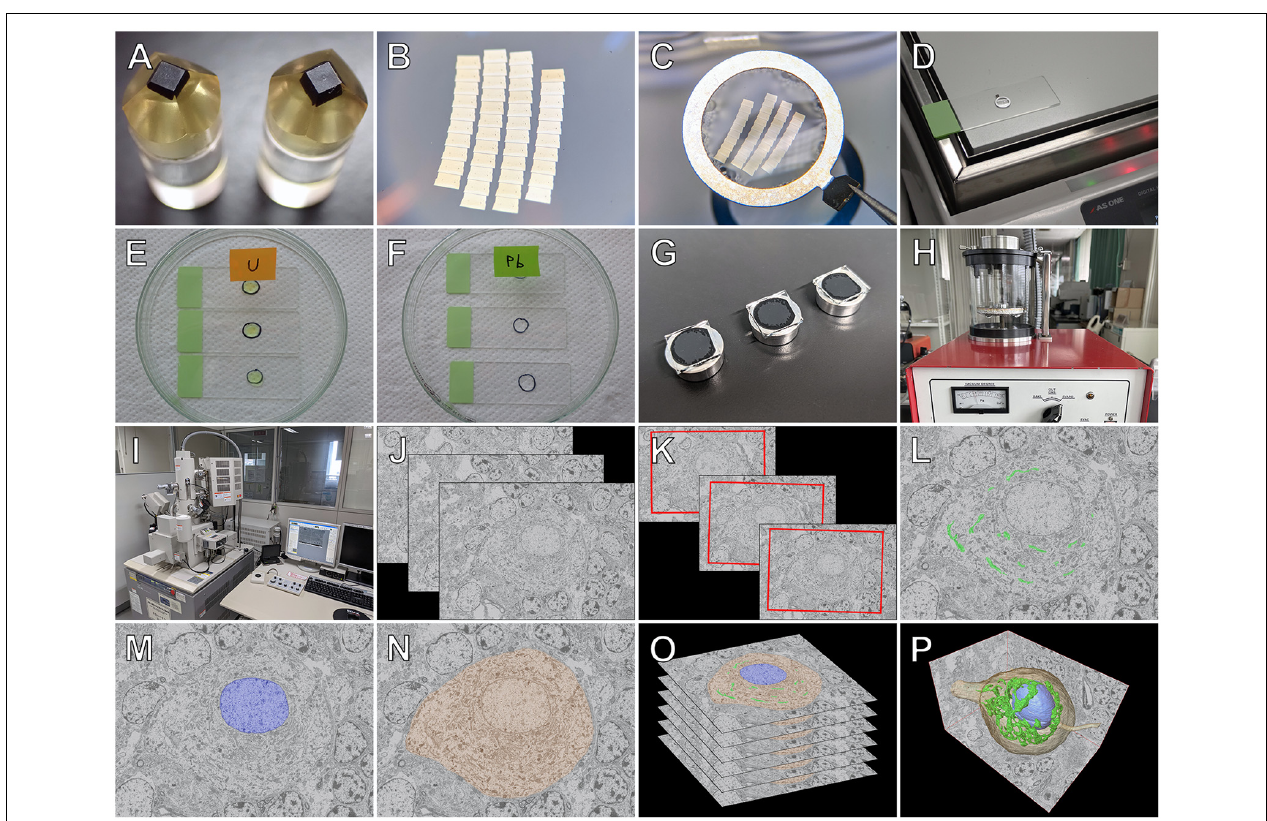
FIGURE 4 | Workflow for serial section SEM. After perfusion fixation, tissues are further fixed with osmium tetroxide and embedded in resin (A) . Several arrays of ribbons with serial ultrathin sections (thickness of 80–100 nm) are cut using a diamond knife (Diatome, B ), picked up with an aluminum loop (Transfer Ring; Microstar) (C) , and attached to glass microscope slides by heating on a hot plate (D) . Several hundred serial sections are obtained by repeating cycles of the sectioning procedure. The serial sections are stained with heavy metals of uranyl acetate (E) and lead citrate (F) , and the glass slides with the serial sections are mounted onto aluminum stubs (G) and coated with carbon using a carbon coater (VC-100S; Vacuum Device) (H) . Regions of interest of the serial sections are imaged using scanning electron microscopy with a backscattered electron (BSE) detector (SU70; Hitachi) (I) . For three-dimensional (3D) reconstruction, BSE images of the serial sections (J) are aligned (K) , and the contours of the structures of interest, such as the Golgi apparatus (L) , nucleus (M) , and cytoplasm (N) , are segmented and stacked (O) . Finally, 3D surface rendering images of the regions of interest are generated (P)